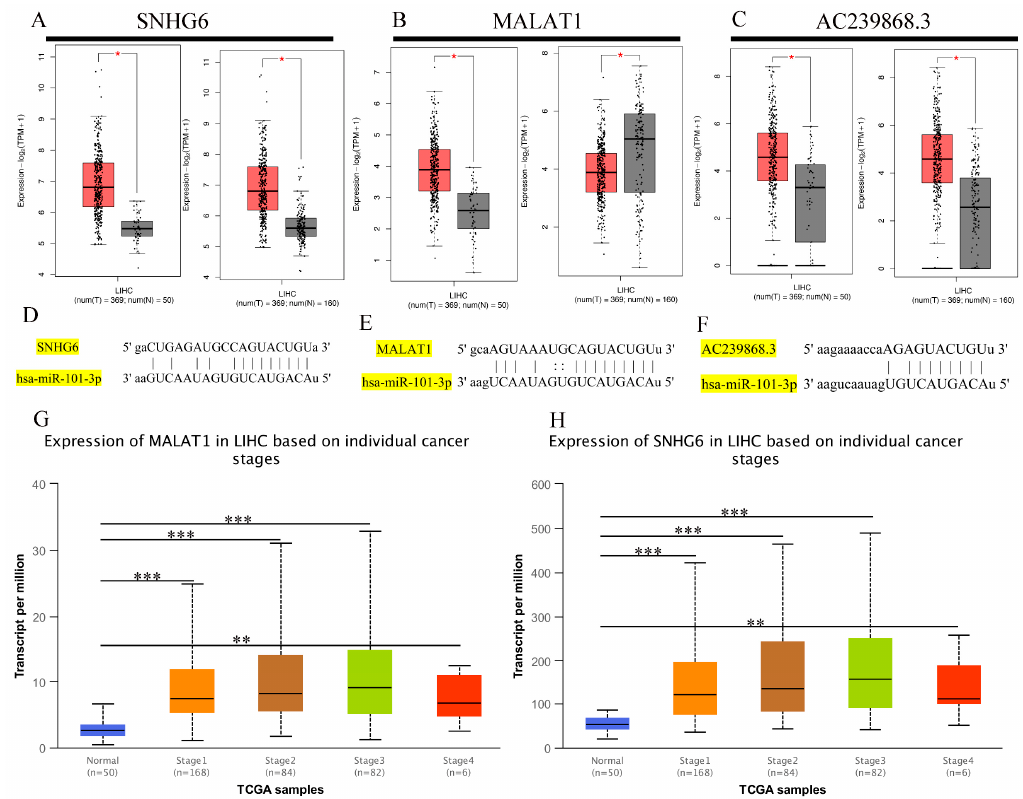
Figure 5. Prediction and identification the potential upstream regulatory miRNAs of EZH2 in HCC. ( A ) The predicted miRNA- EZH2 network. ( B ) The correlation between the candidate miRNAs and EZH2 in HCC, where red represents a positive correlation and blue represents a negative correlation. ( C , D ) Differential expression analysis of hsa-miR-101-3p and hsa-miR-26b-5p in HCC tissues and normal tissues. ( E , F ) Prognostic analysis of hsa-miR-101-3p and hsa-miR-26b-5p in HCC. ( G ) Pairing information of hsa-miR-101-3p and EZH2 .